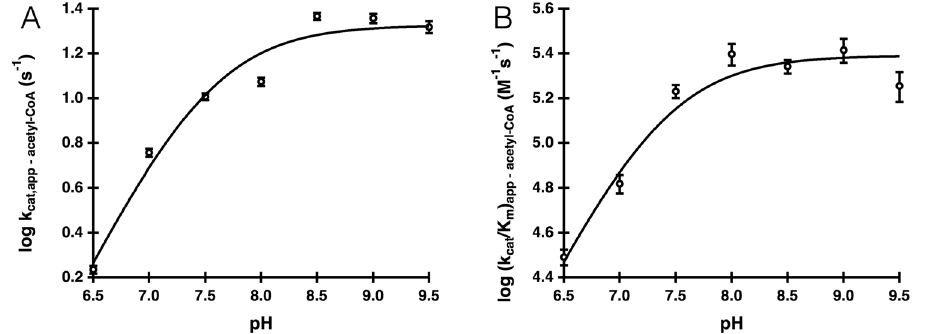
Figure 5. Wild-type pH-rate profiles. ( A ) k cat,app for acetyl-CoA. ( B ) (k cat /K m ) app for